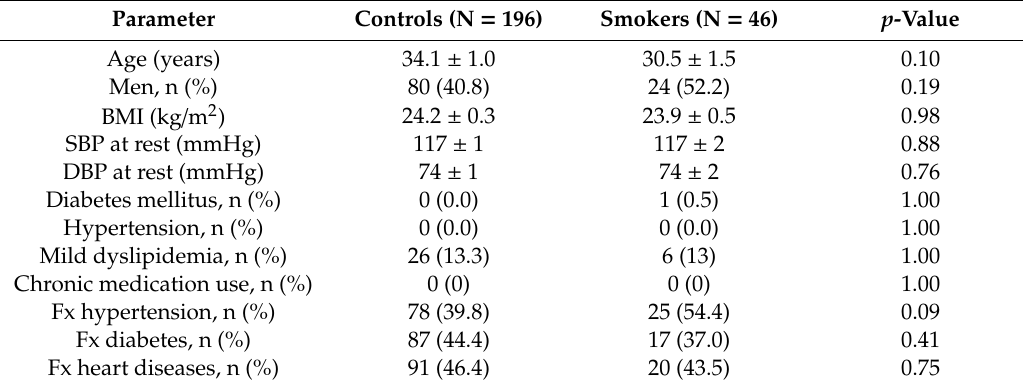
Table 1. Clinical characteristics of the study participants.